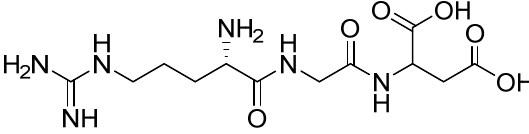
Figure 4. Structure of RGD (Arg–Gly–Asp) peptide.